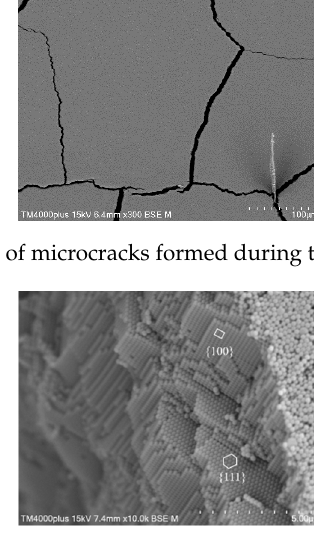
Figure 6. Cross-sectional SEM image of the P(St-MMA-AA) colloidal crystal coating.